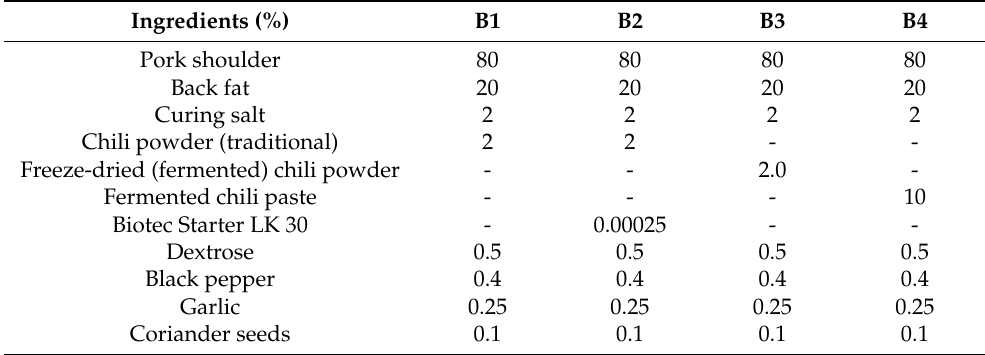
Table 1. Formulations of salami samples and their codifications according to the different sources of fermenting microorganisms used during